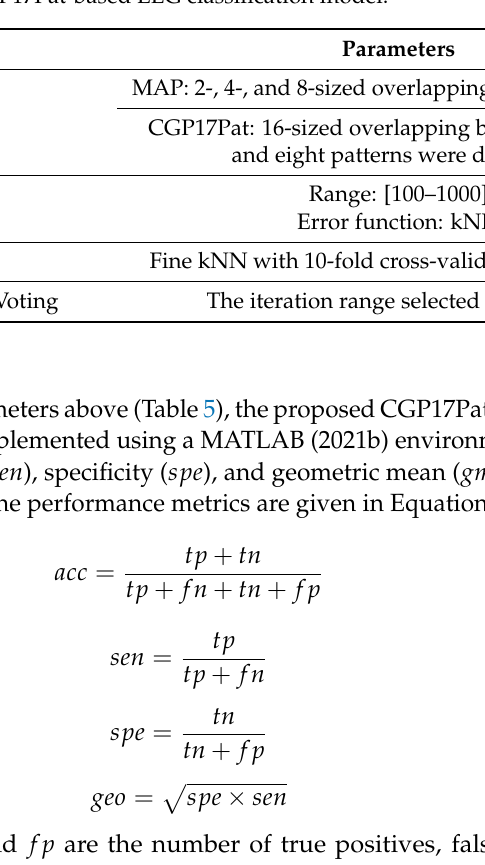
Table 5. Parameters of our CGP17Pat-based EEG classification